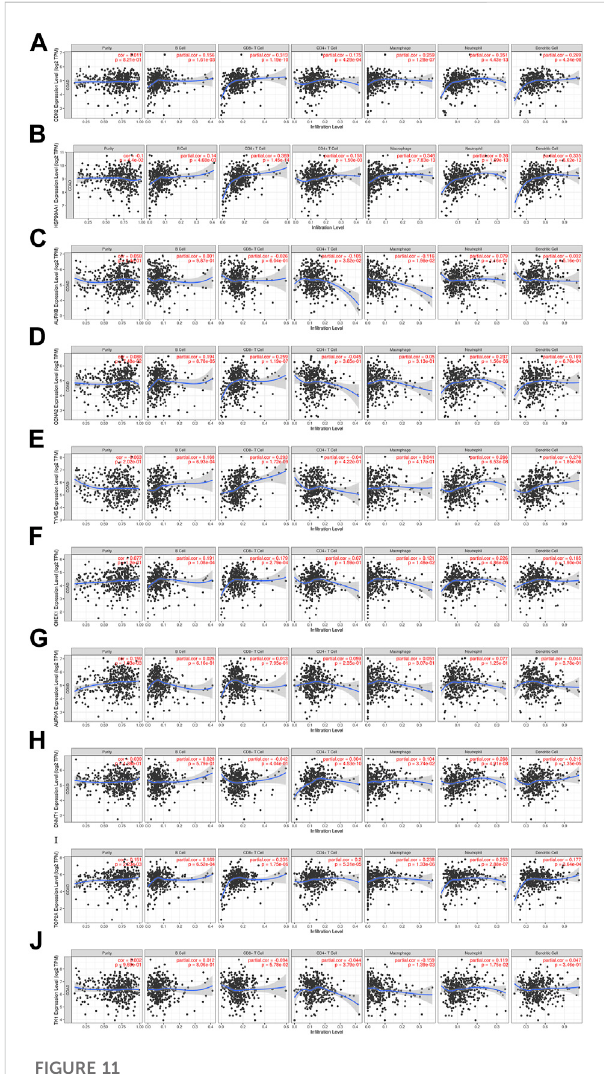
FIGURE 11 Relationship between differentially expressed core targets and immune cell in fi ltration. ( (A) . CDK2, (B) . HSP90AA1, (C) . AURKB, (D) . CCNA2, (E) . TYMS, (F) . CHEK1, (G) . AURKA, (H) . DNMT1, (I) . TOP2A, (J) .